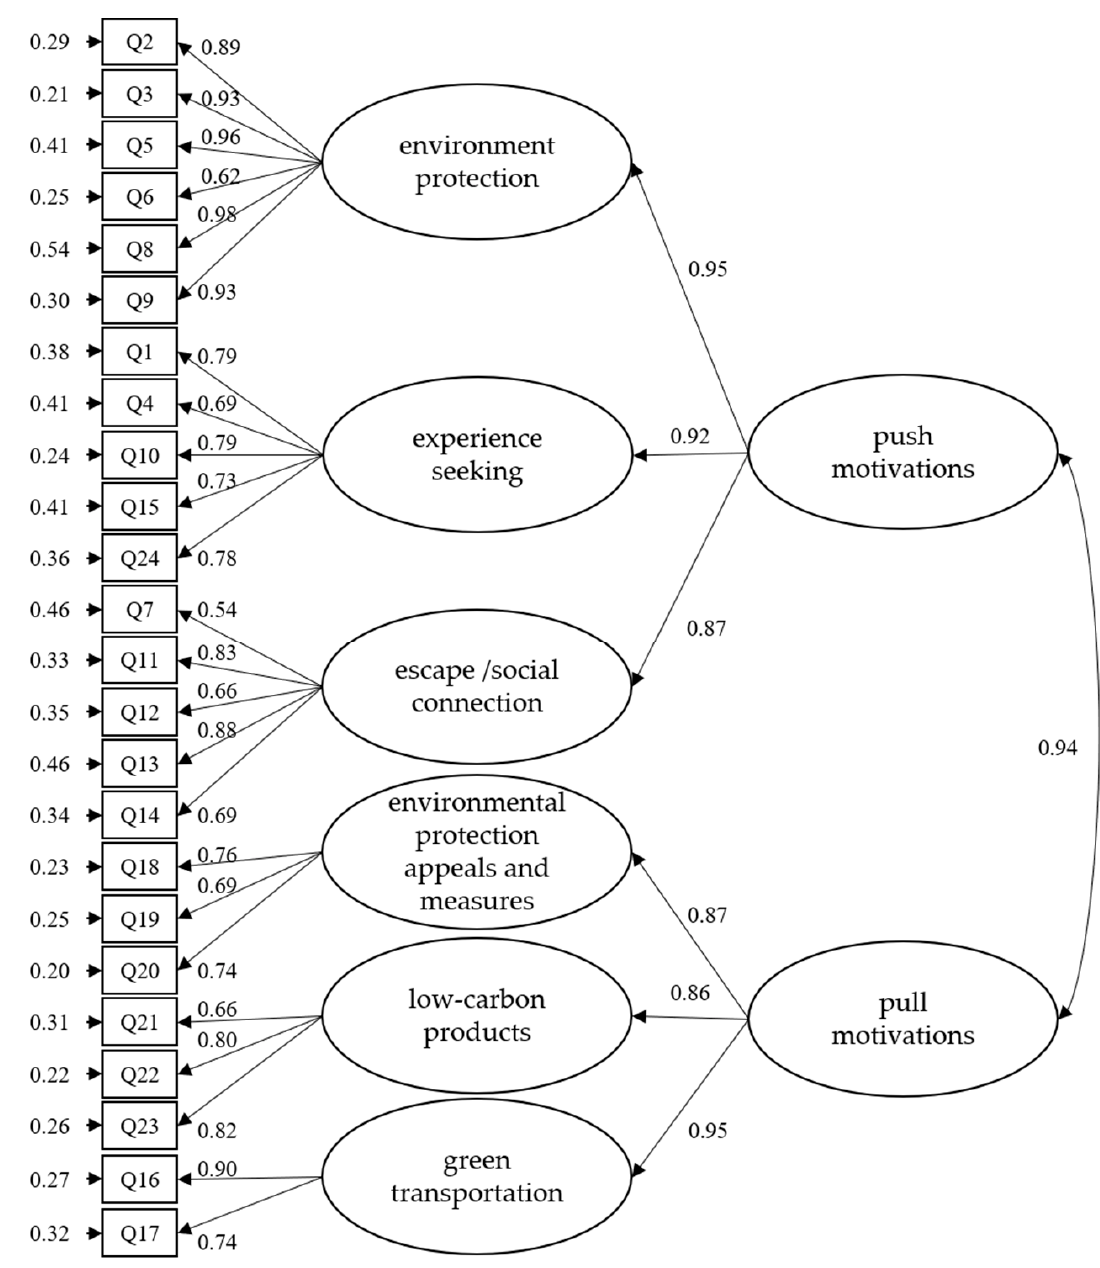
Figure 2. The second-order model of LCTMS.